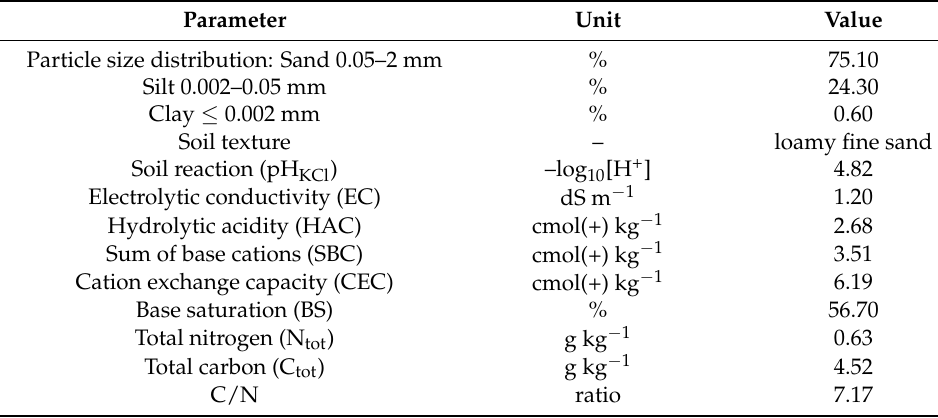
Table 1. Characteristics of the soil used in the